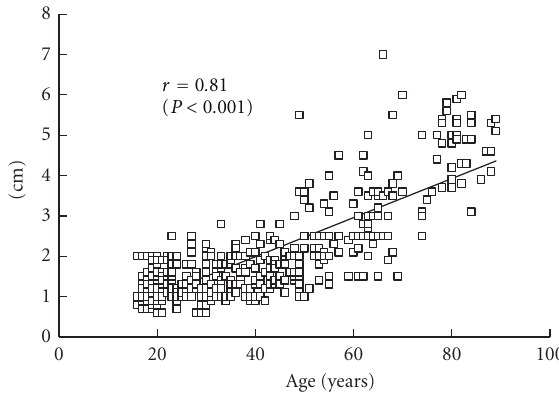
Figure 5: Relation between two-point discrimination and age ( n = 579). there was a significant positive correlation between age and two-point discrimination ( r = 0 . 81, P < 0 .